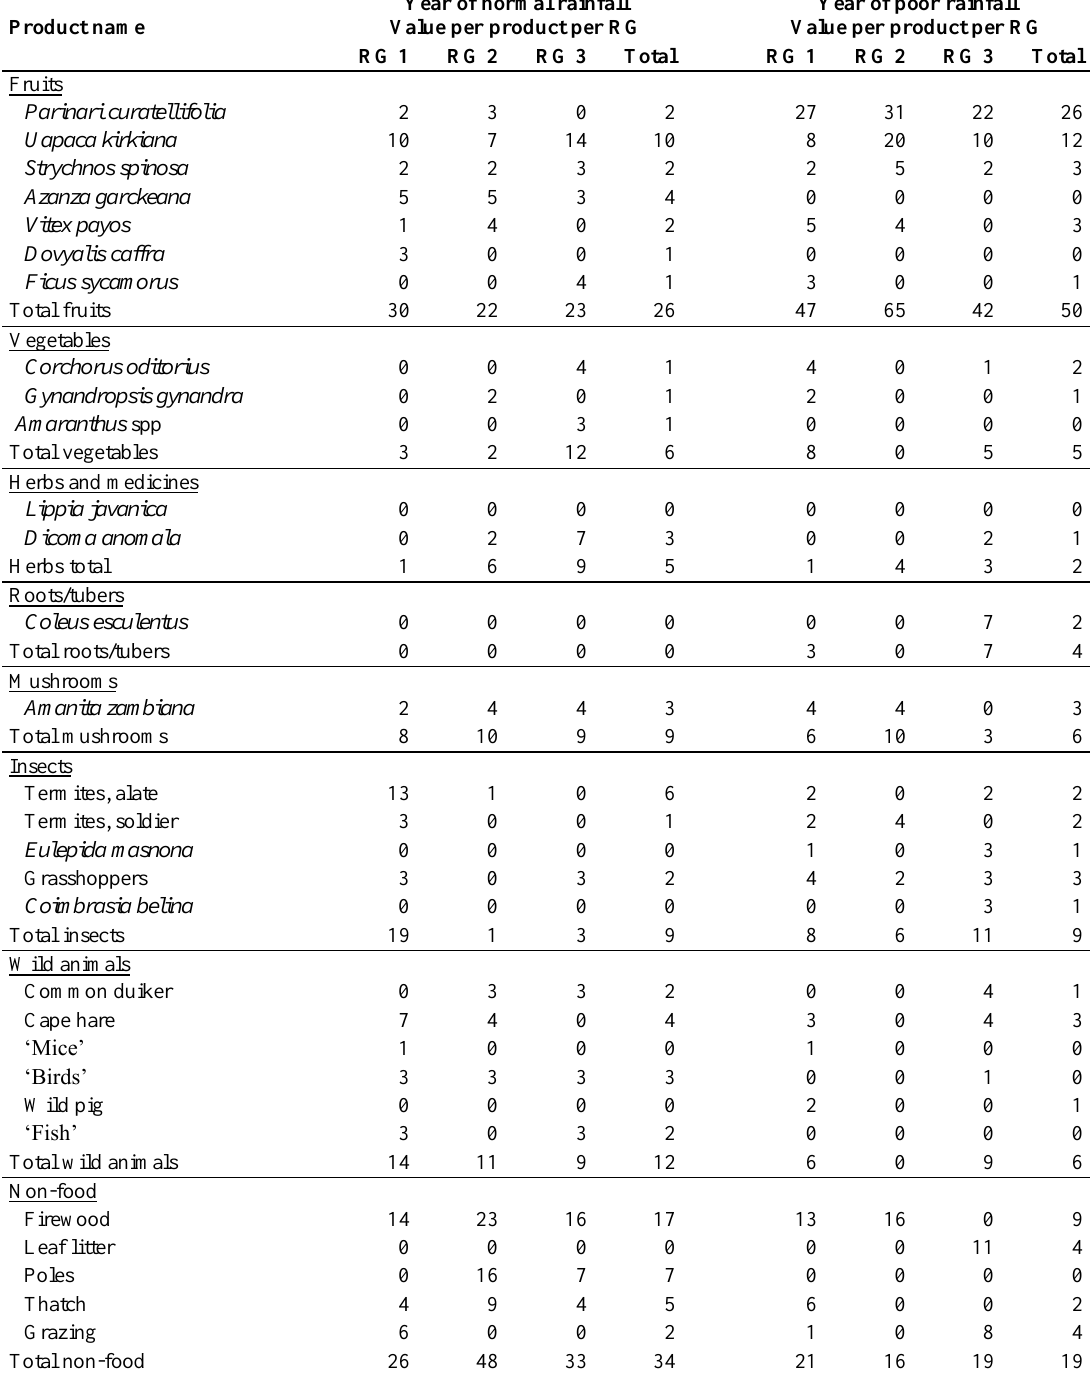
Table A1.1: Farmer’s valuation of NTFPs, based on a valuation exercise in which farmers selected the NTFPs that were most important to their household and ranked these. Values shown are relative values, and can be compared vertically, horizontally and between product groups. Total values in an entire column add up to